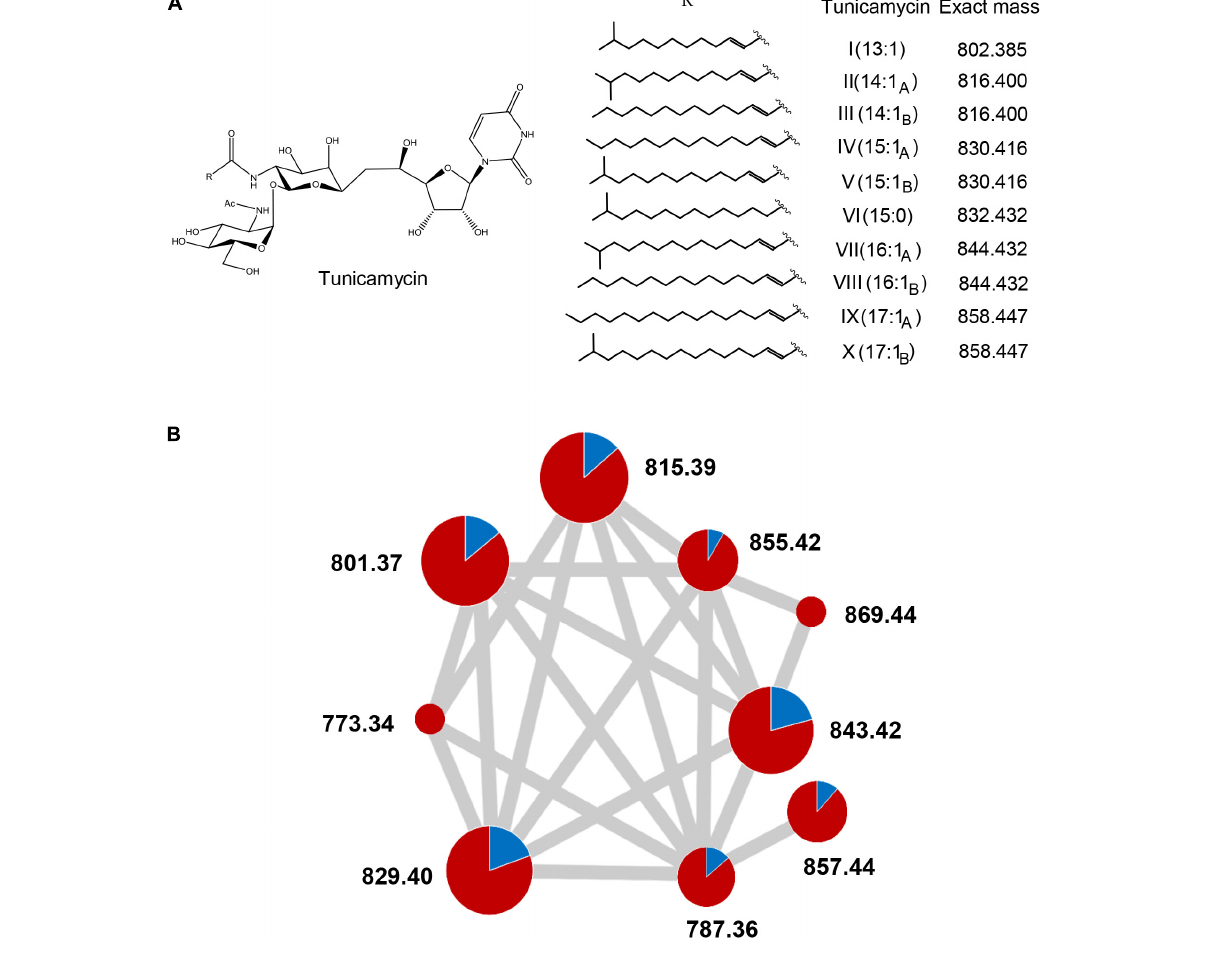
FIGURE 5 | Structure of tunicamycins and overproduction in S. clavuligerus::pimM . (A) Structure and diversity of known tunicamycins. (B) Tunicamycin molecular networking analysis showing a network corresponding to the tunicamycins detected in S. clavuligerus:: pIB139 (blue) and S. clavuligerus::pimM (red). The circles situated in the nodes of the network represent the relative amounts of each tunicamycin congener in each strain. The three different circle sizes arbitrarily represent dominant, intermediate and minor levels of abundance within the tunicamycin complex (accurate absolute ion count values are shown in Supplementary Figure S6 ). The gray edges joining the nodes correspond to the existence of shared MS 2 signals, as identified by GNPS (Wang M. et al.,